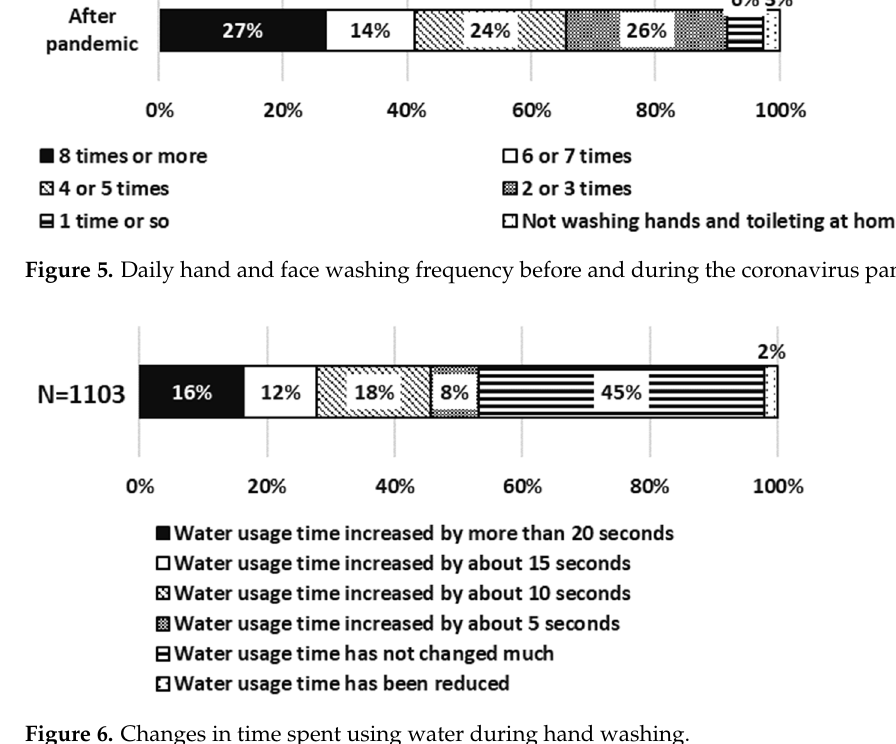
Figure 6. Changes in time spent using water during hand washing.